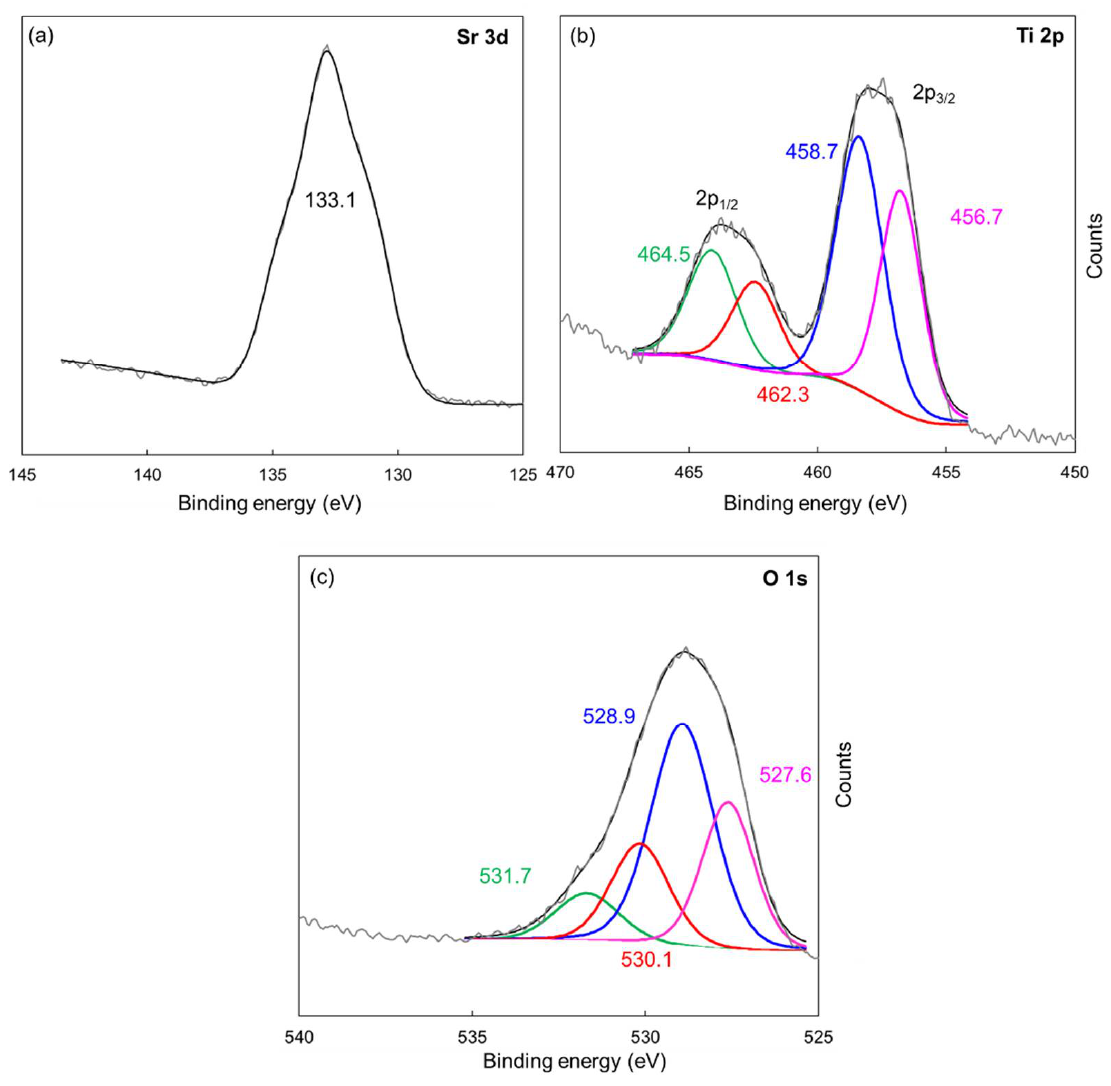
Figure 3. XPS HR spectra of Sr 3d, Ti 2p, and O 1s of STOn.